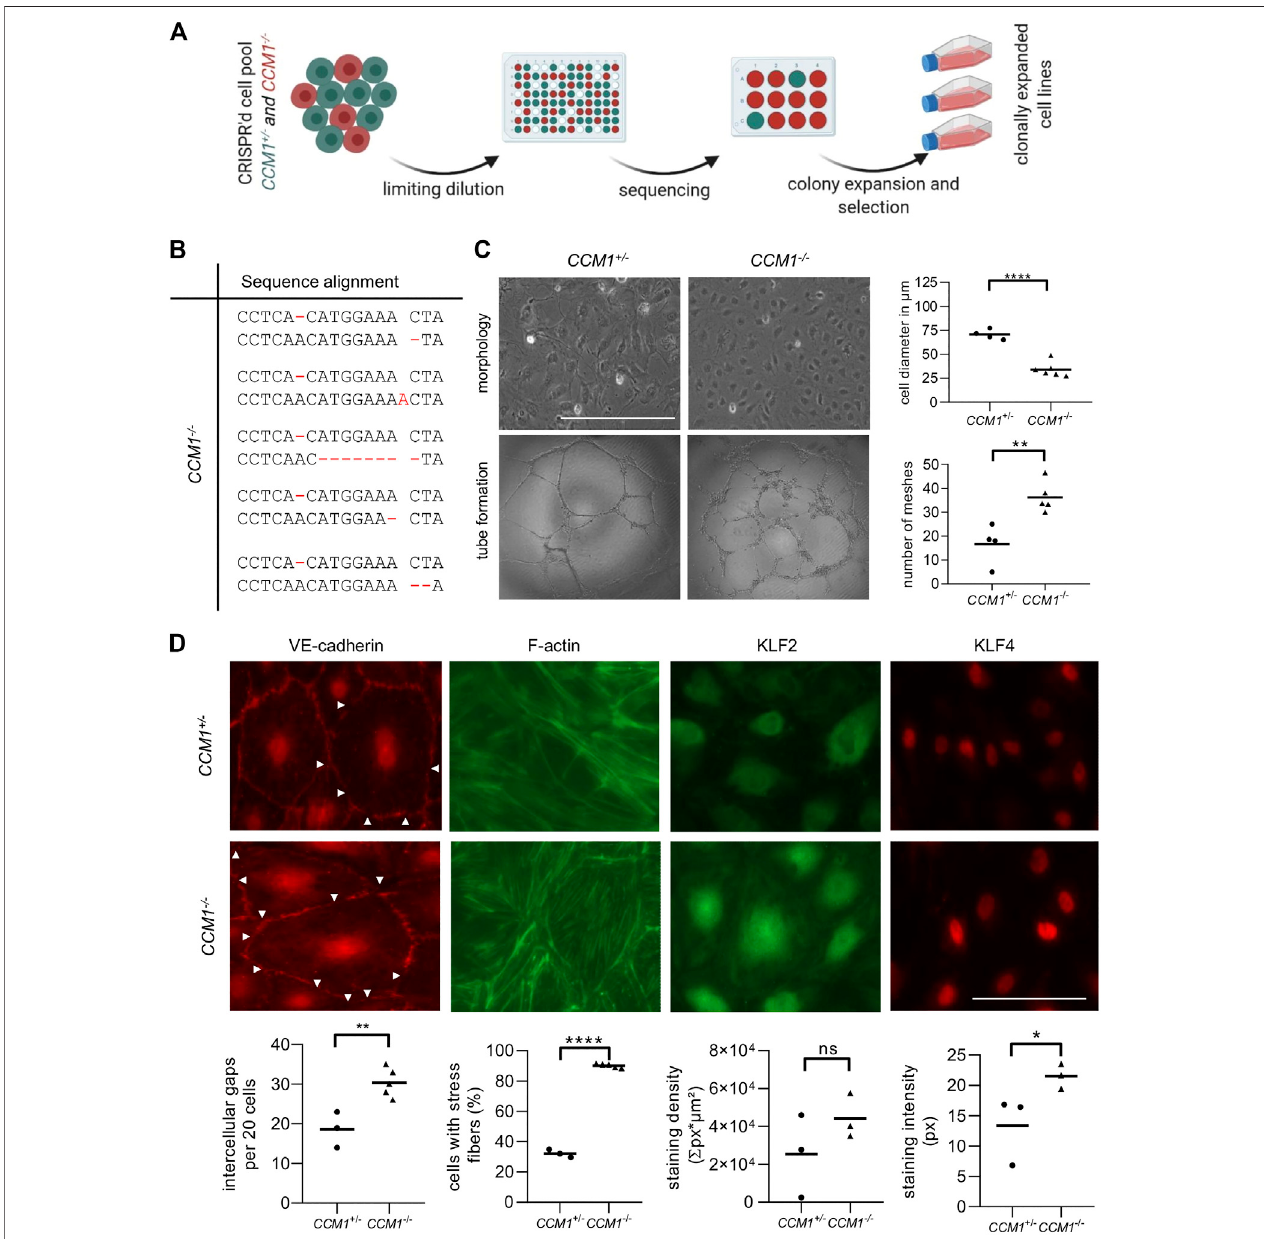
FIGURE 2 | Characterization of CCM1 +/ − and clonally expanded CCM1 − / − BOECS. (A) CCM1 − / − BOECs were established by limiting dilution of the CRISPR/Cas9 RNP-treated cell pool and clonalexpansion of single cells (created with BioRender.com). (B) Shown are the genotypes of CCM1 − / − BOEC clones included in this study. All variants either lead to a frameshift or a premature stop codon (additional information on the CRISPR/Cas9-induced mutations and numbers of individual clones are given in Supplementary Table S1 ). (C) CCM1 − / − BOECs presented a more compact morphology in bright fi eld microscopy and increased tube formation. The largest cell diameter and the number of meshes formed on Matrigel-coated plates were quanti fi ed. Scale bar indicates 400 µm. Data are presented as single data points with the mean ( n (cid:2) 4 – 6). (D) Immuno fl uorescence staining revealed a higher number of intercellular gaps (white arrowheads), more actin stress fi bers, and a higher expression of KLF2 and KLF4 in CCM1 − / − BOECs. Representative images are shown. Scale bar indicates 100 µm. Individual data points are shown with the mean ( n (cid:2) 3 – 5). Student ’ s t test was used for statistical analysis: * p < 0.05; ** p < 0.01; **** p < 0.0001; ns (cid:2) not signi fi cant; VE-cadherin (cid:2) vascular endothelial cadherin.